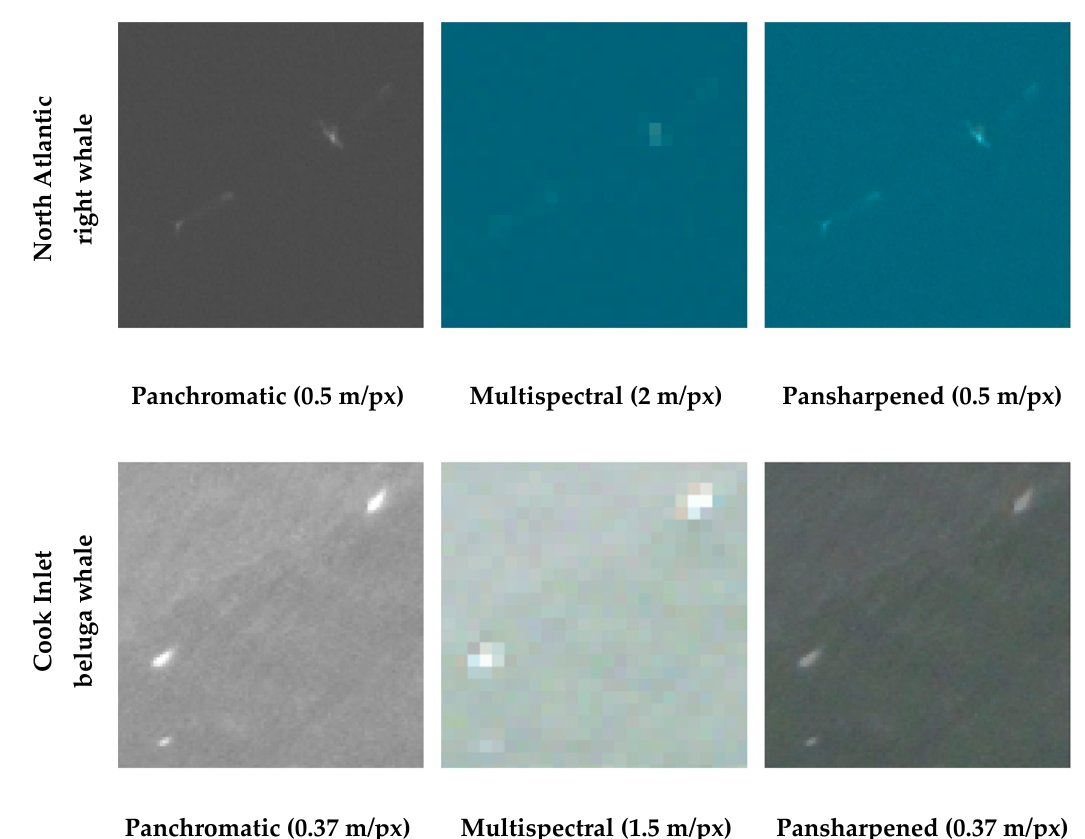
Figure 8. Example of very high-resolution panchromatic imagery, lower-resolution multispectral RGB imagery, and the resulting pansharpened product (Brovey pansharpening) of two right whales in Cape Cod Bay, Massachusetts (Top row, Catalog ID: 10400100674B2100, WorldView-3, Standard 2A product) and three beluga whales in Cook inlet, Alaska (bottom row, Catalog ID: 104001006F3F8E00, WorldView-3, Basic 1B product). Satellite images © 2023 Maxar